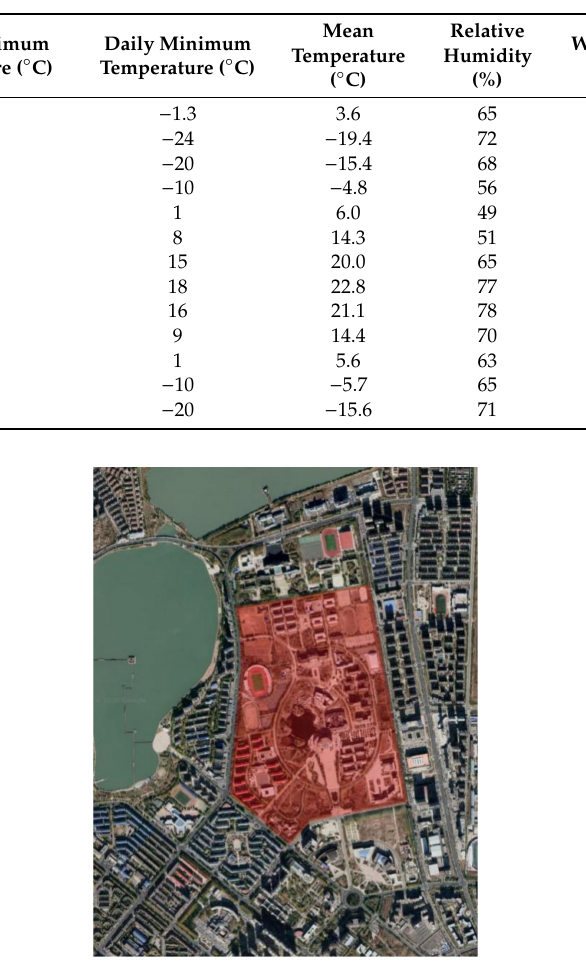
Figure 1. The campus and surrounding